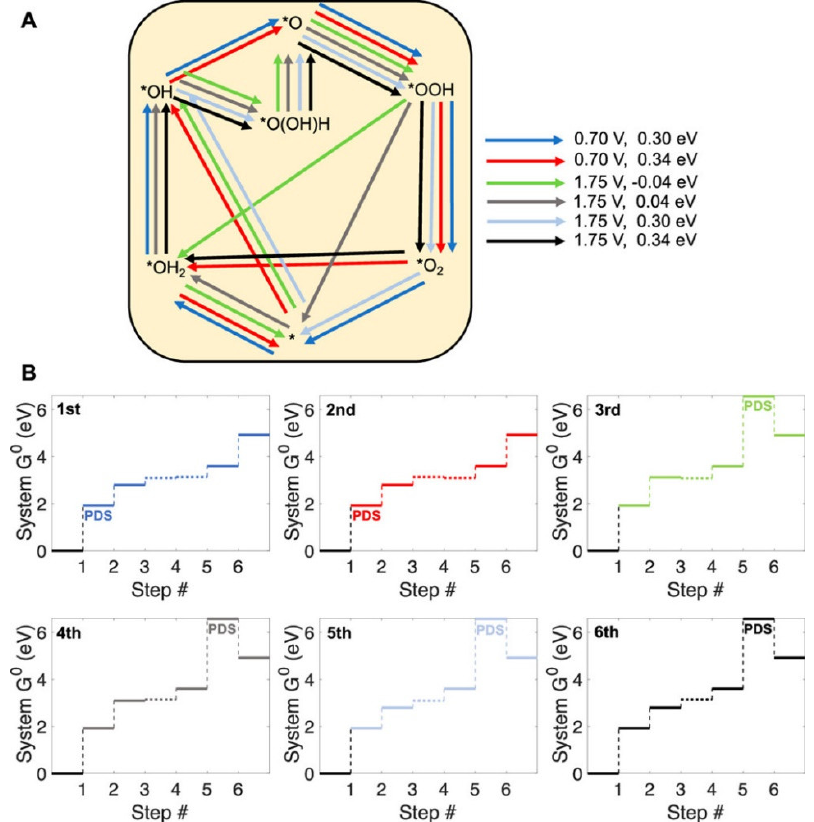
Figure 37. ( A ) Schematic of six automatically enumerated OER mechanisms discovered on β-NiOOH (0001). The corresponding thermodynamic overpotentials (V) and the highest non-electroactive Gibbs free energy steps (eV) are indicated. ( B ) Energetic profiles for six mechanisms by PBE+U ( U eff = 5.5 eV). (Reprinted from ref. [216] with permission from the Journal of Physical Chemistry C. Copyright 2020, American Chemical